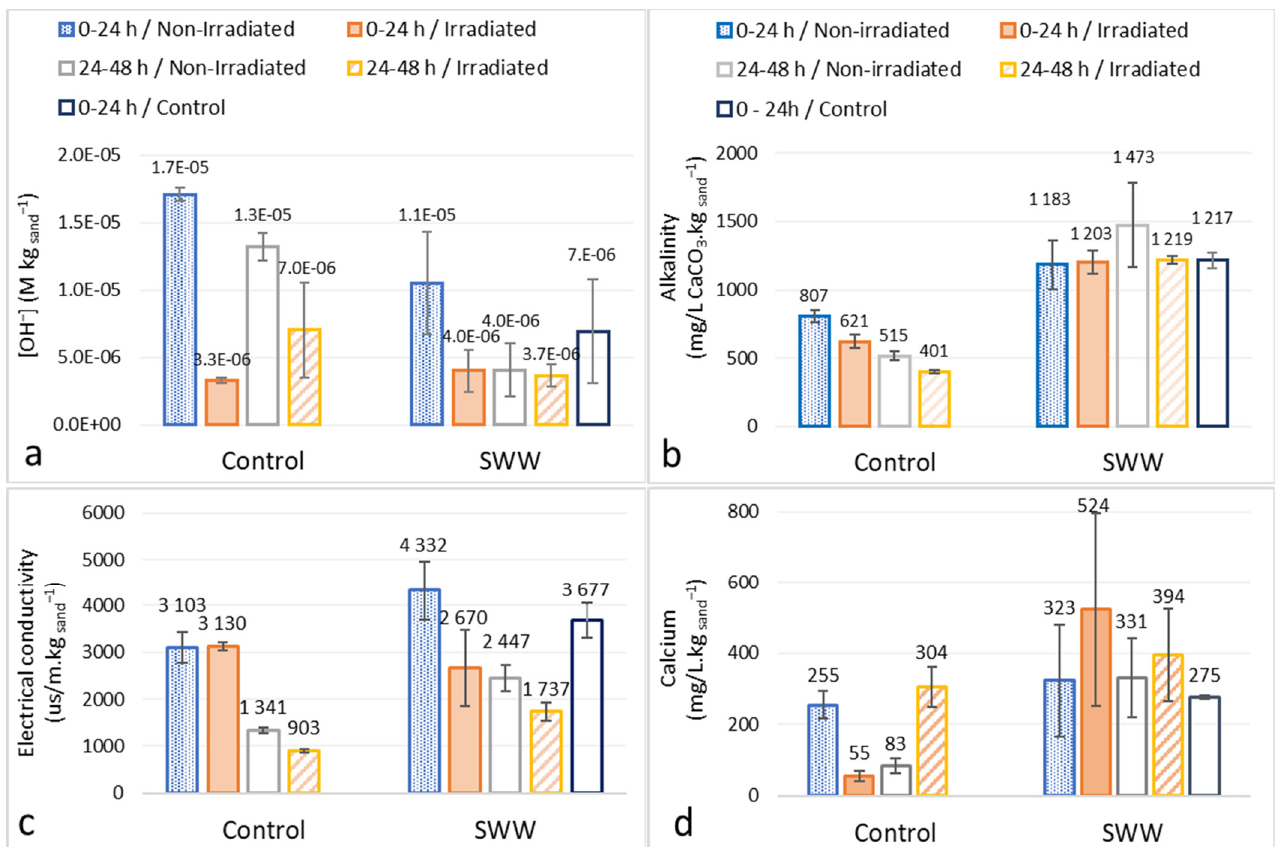
Figure 4. Average specific concentrations of hydroxide ions ( a ), alkalinity ( b ), electrical conductivity ( c ) and calcium ( d ) in column eluent ( n = 3 replicates, error bars represent standard deviation from the mean).